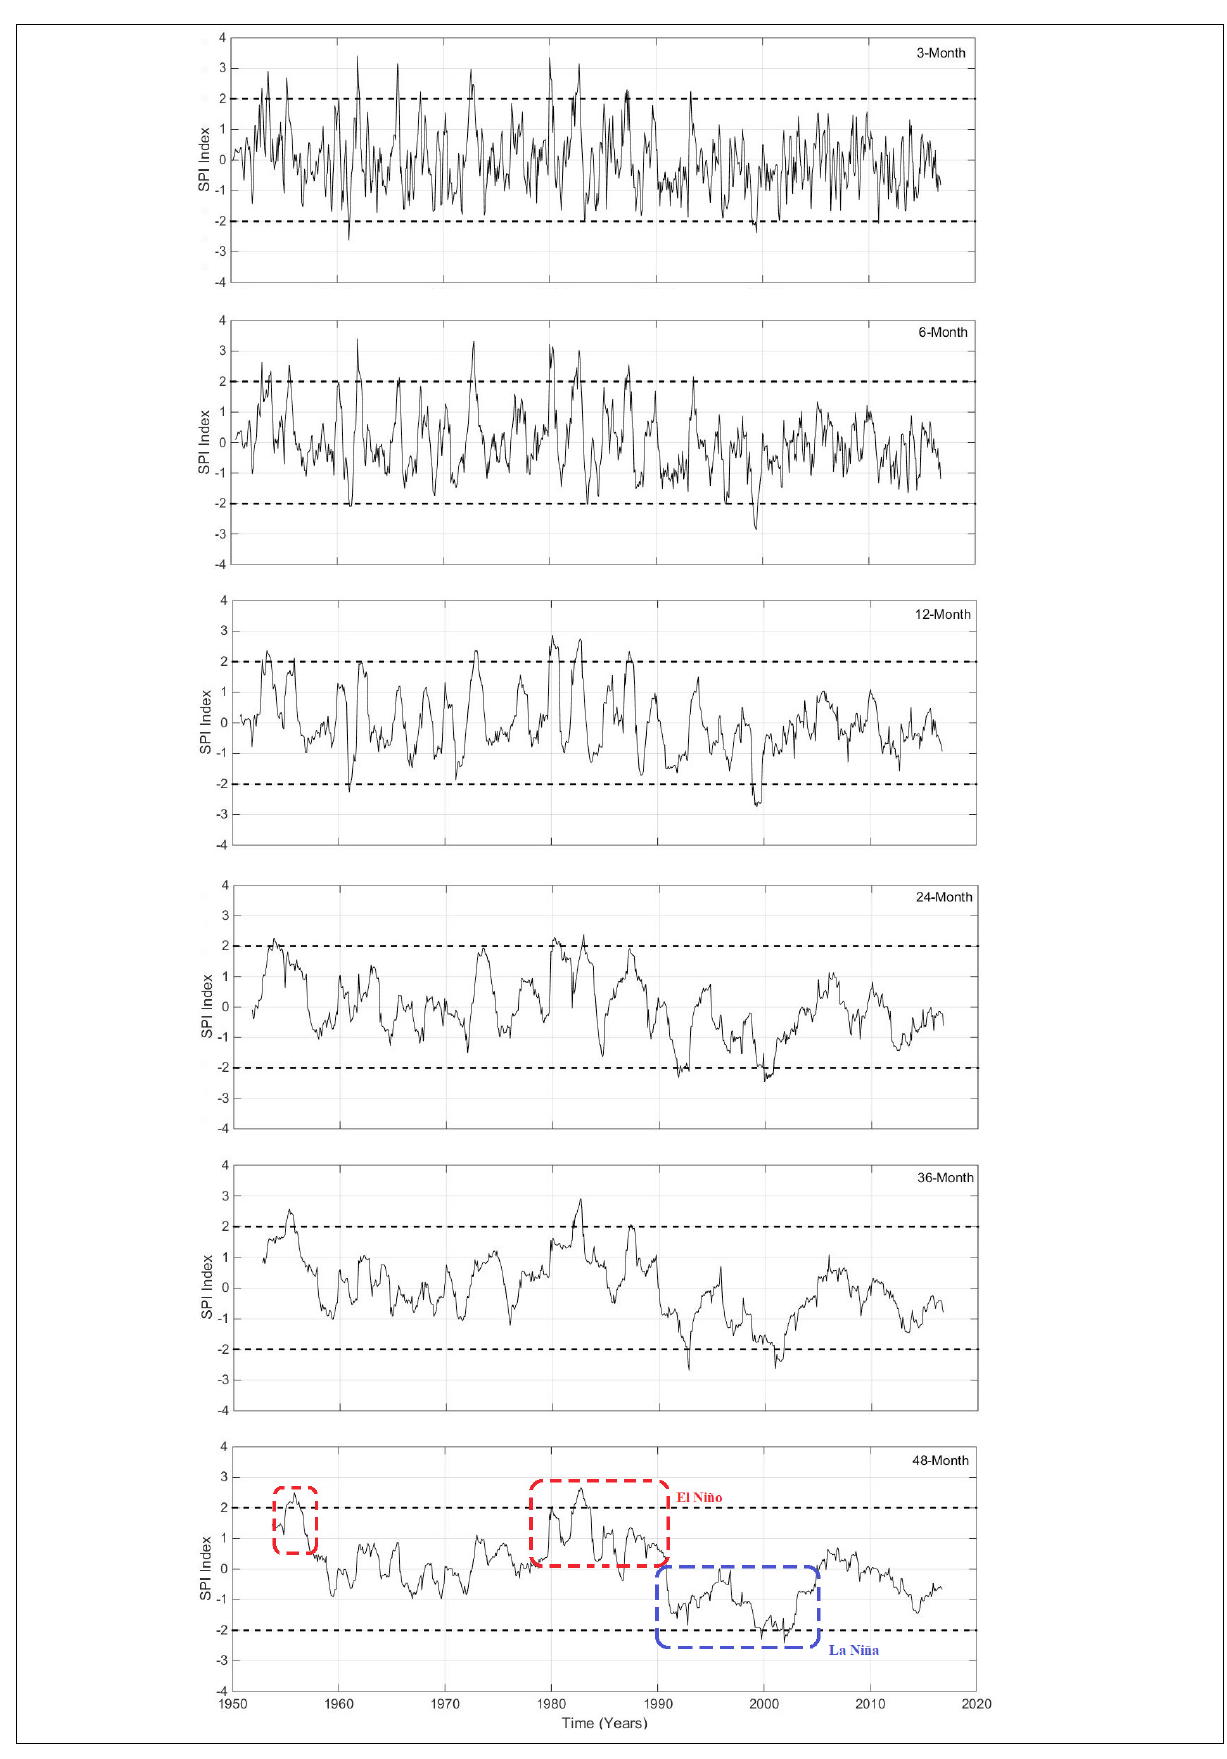
Figure 6: Standardised Precipitation Indices for rainfall over Mauritius during the period